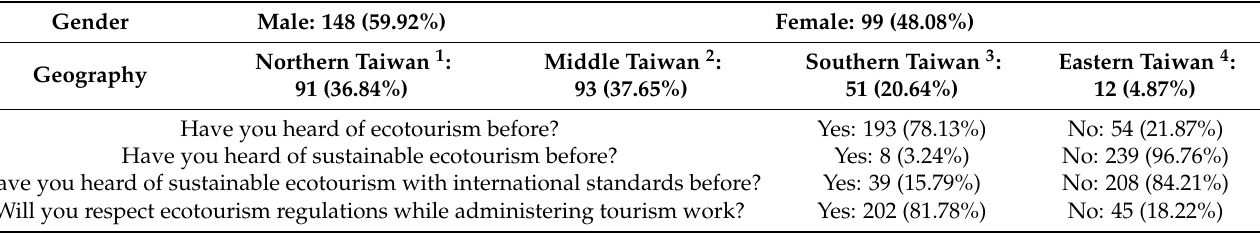
Table 1. Descriptive statistics of the FA approach.